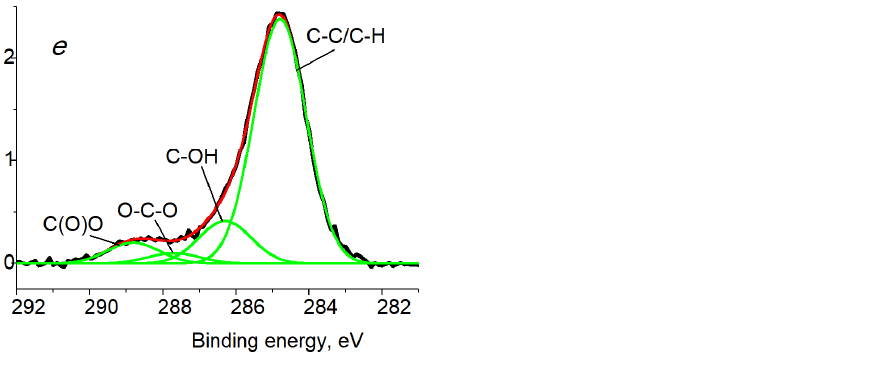
Figure 7. The C 1s photoelectron spectra of samples BCF ( a ), Ag NPs/BCF ( b ), SBCB ( c ), Ag NPs/SBCB ( d ) and Ag NPs ( e ).